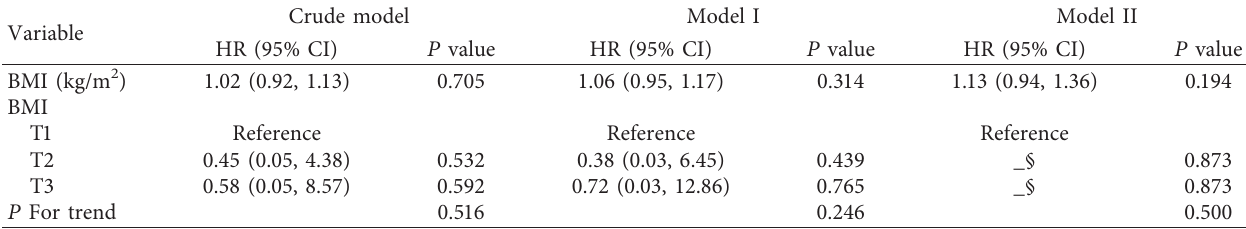
Table 3: Relationship between BMI and readmission of AMI in different models.